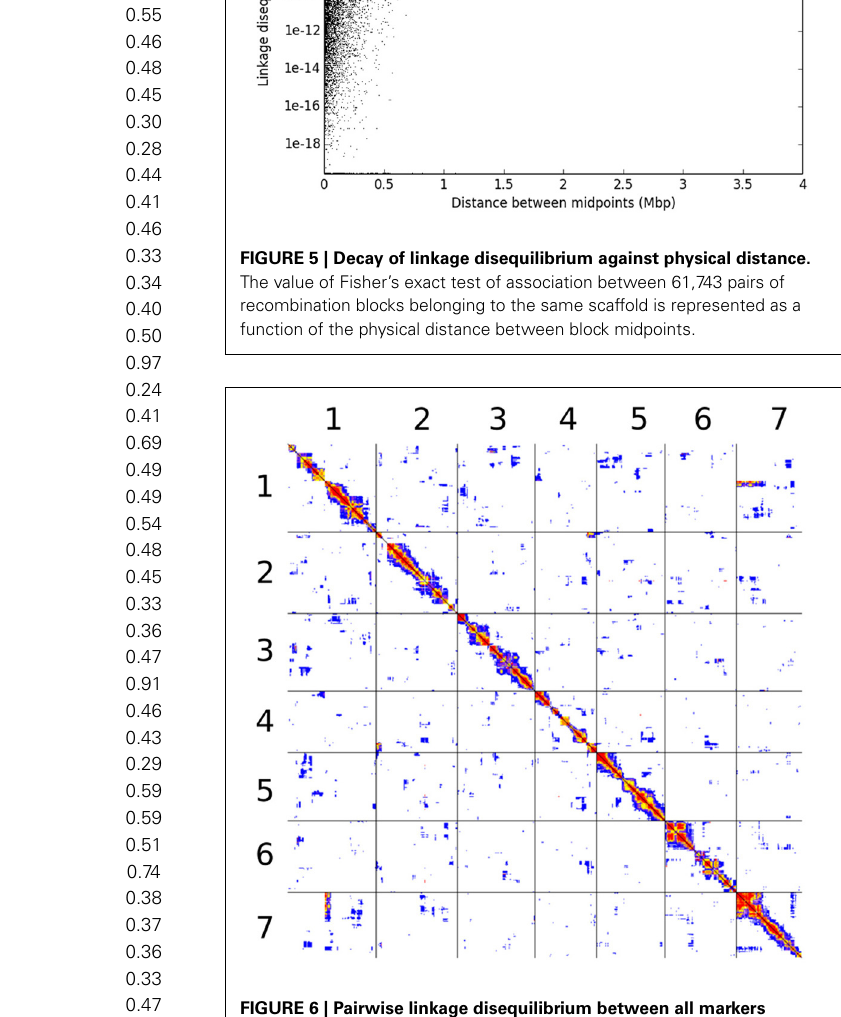
FIGURE 6 | Pairwise linkage disequilibrium between all markers belonging to assembly scaffolds 1 through 7. The figure does not account for physical distance. Black lines separate scaffolds. All pairs are represented twice, above and below the diagonal. Each pair is represented by a single pixel. The color code is based on Fisher’s exact test P -value: red, P < 10 − 10 ; orange, P < 10 − 8 ; yellow, P < 10 − 6 ; purple, P < 10 − 4 ; blue, P < 10 − 2 ; white, larger P -values or not